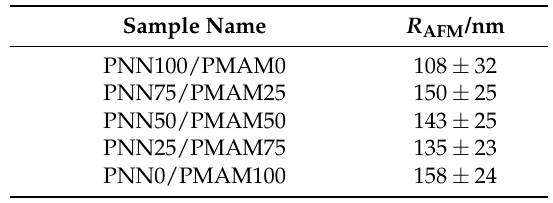
Table 2. Lateral radii R AFM of all dried core-shell microgel particles obtained from the AFM images presented in Figure 2. The errors were extracted from the standard deviations of R AFM . The lateral radius of the core microgels was 88nm (No corrections with respect to the tip profile were